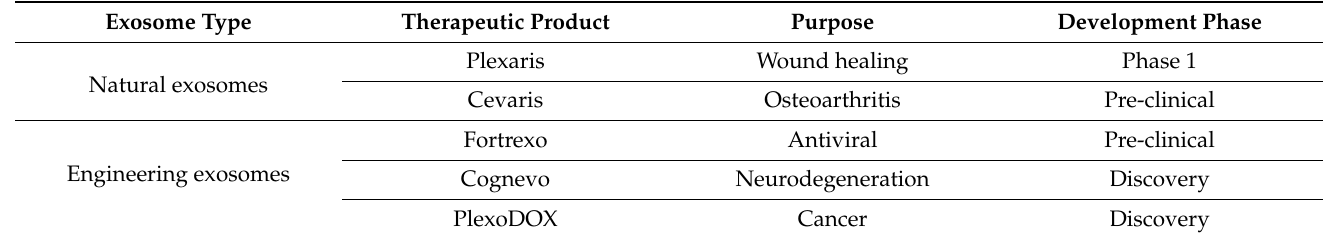
Table 9. Therapeutic products from Exopharm Pty Ltd.